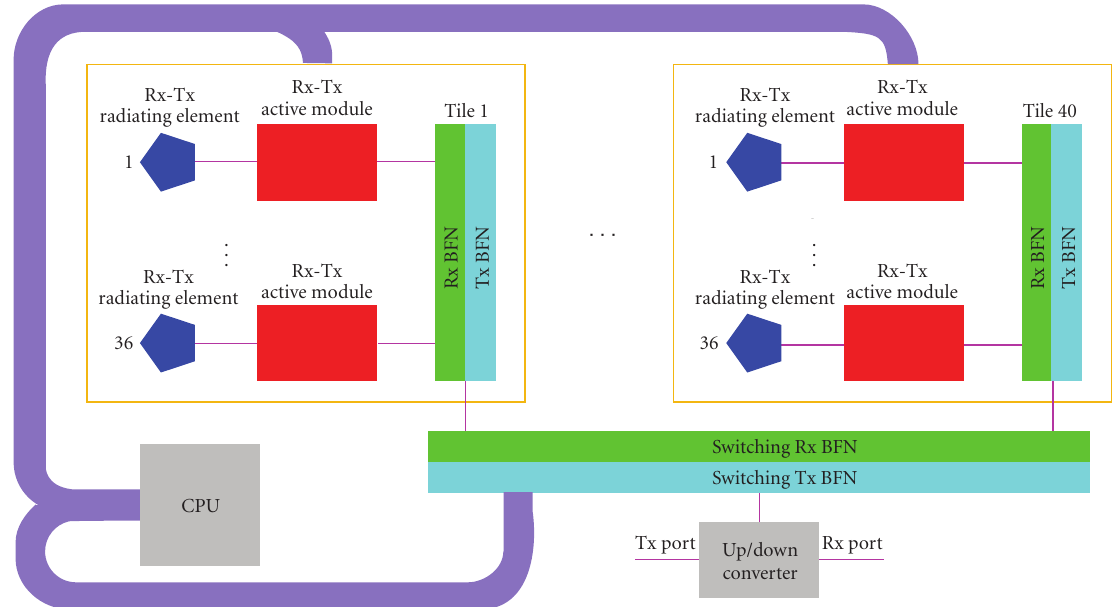
Figure 4: Hemi-spherical antenna block diagram.